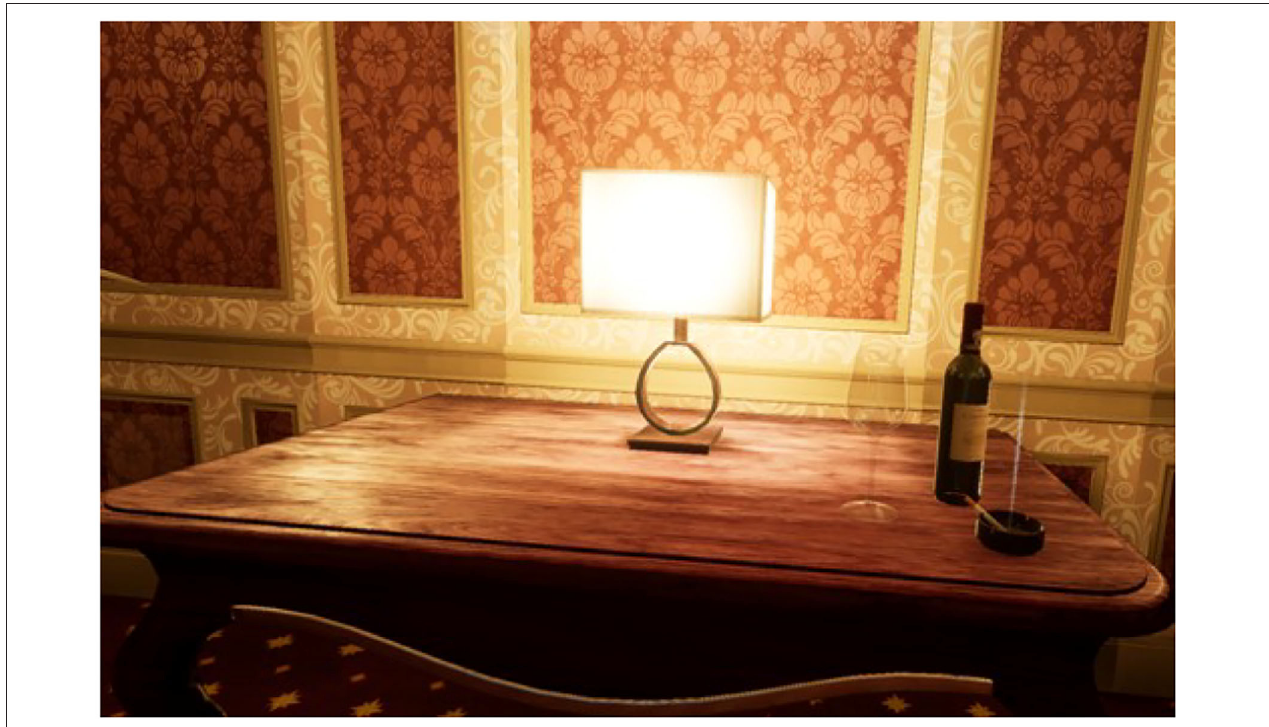
FIGURE 8 | A red wine bottle, a wineglass and a lit cigarette in the slot